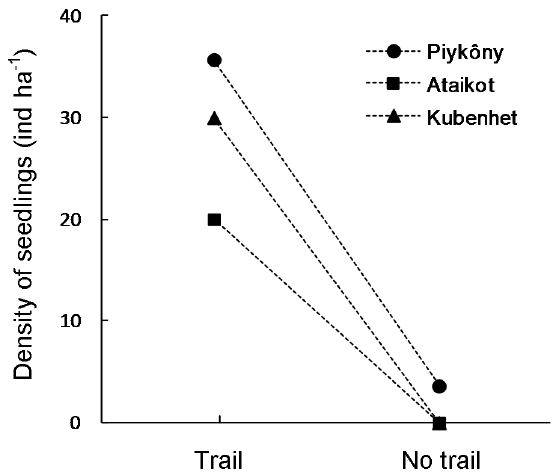
Figure 3. Comparison of B.excelsa seedling density along trails and in parallel transects away from trails. Each point represents one of the transects in the territory of A’Ukre village, Kayapo ´ Indigenous Land, southeastern Amazonia. The three points on the left are transects located along the main trails used to transport Brazil nuts from groves to the village and the three points on the right are transects parallel to those trails and 100m from them. Points with the same symbol represent pairs of along-trail and away-from-trail transects.